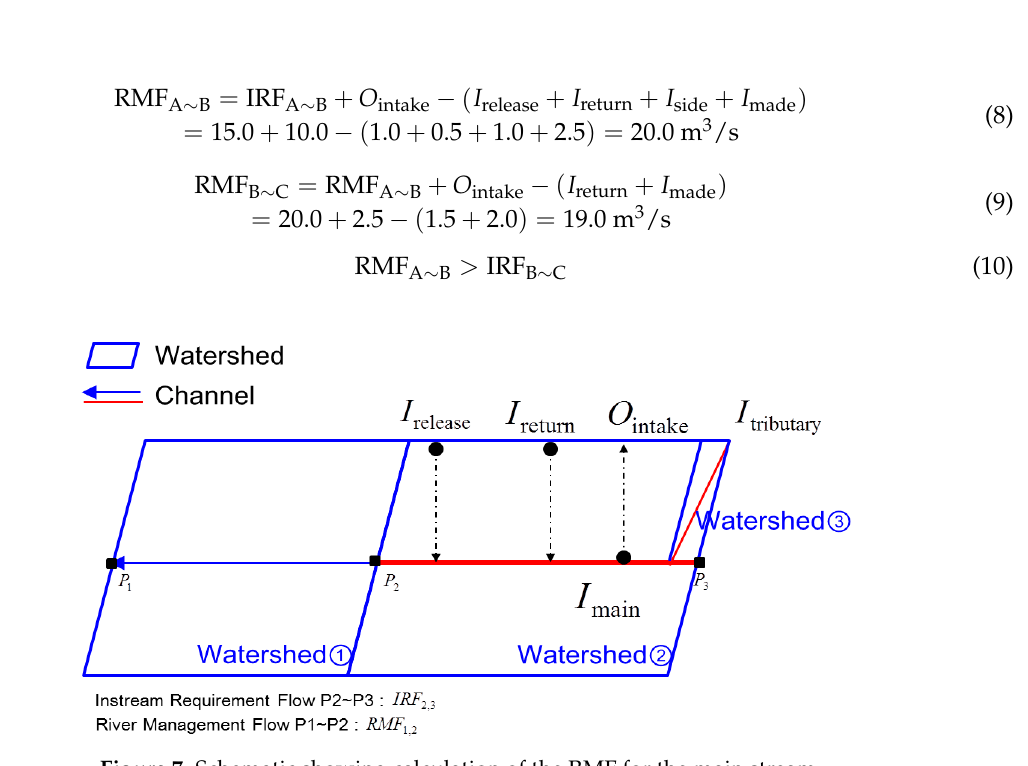
Figure 8. Example of the calculation of RMF.